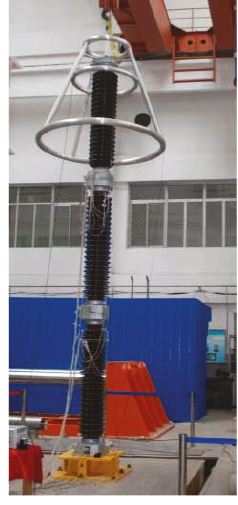
Figure 1: High voltage insulator.